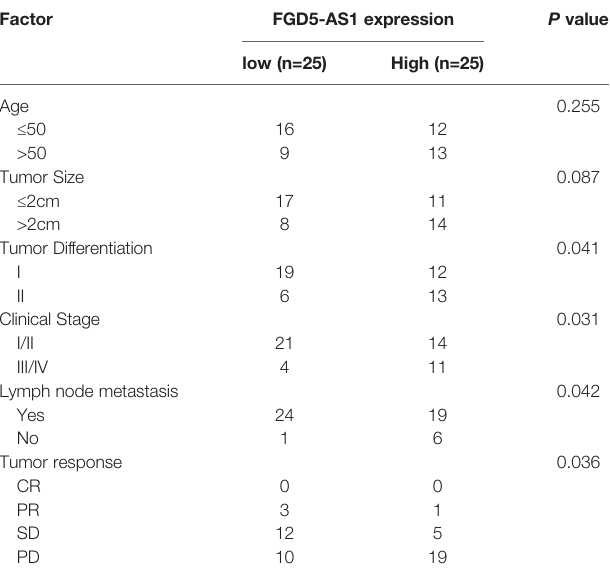
TABLE 1 | Correlations of FGD5-AS1 expression with clinicopathologic features of breast cancer.